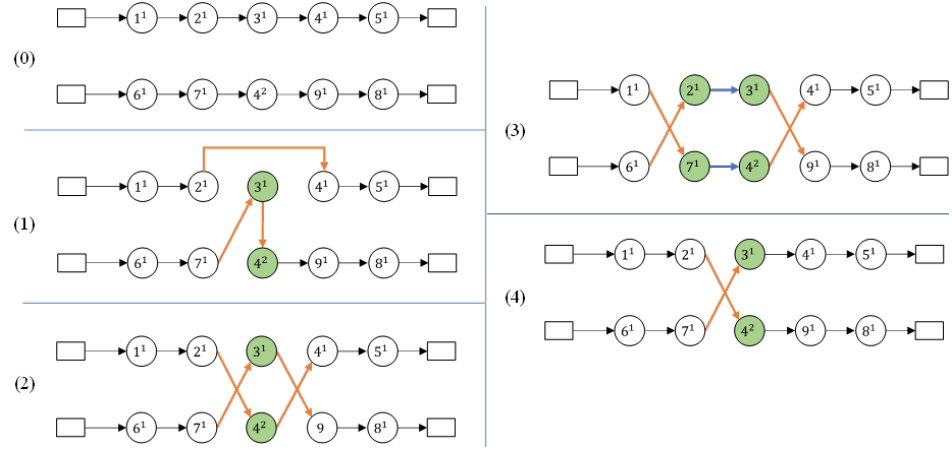
Figure 5. Intra-line operations.